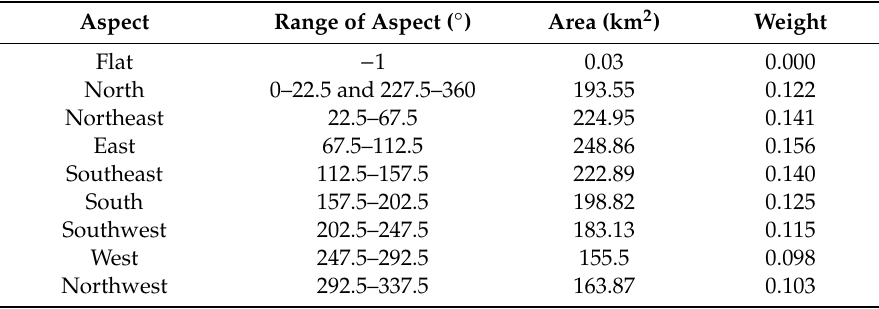
Table 2. Aspect classification of Gongga